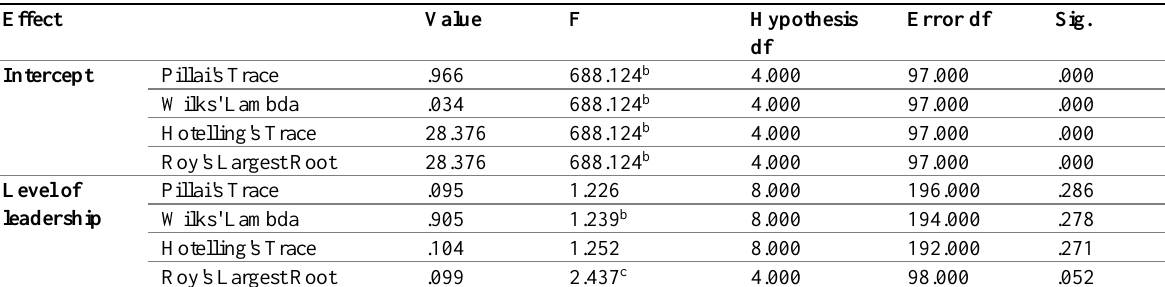
Table 8: Multivariate Tests